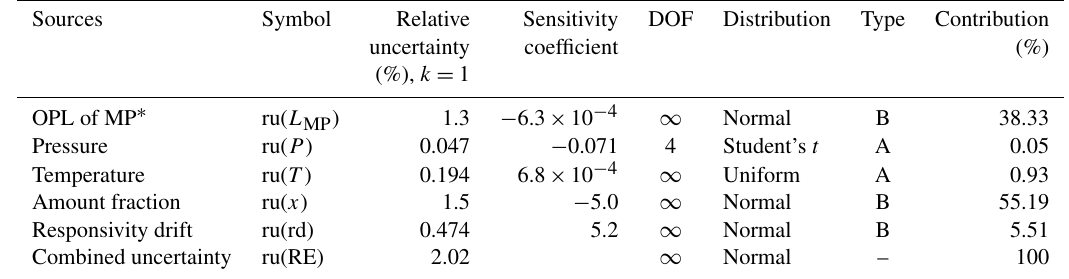
Table 3. Uncertainty budget for radiative efficiency of Novec-4710 (representative example; others are presented in the Supplement).